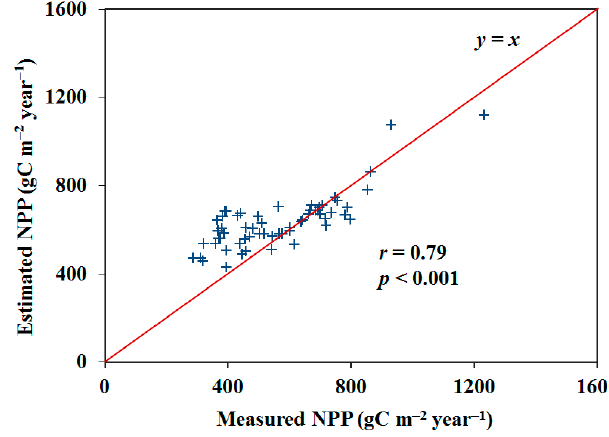
Table 3. Statistics of the estimated NPP performances at 59 field sites.